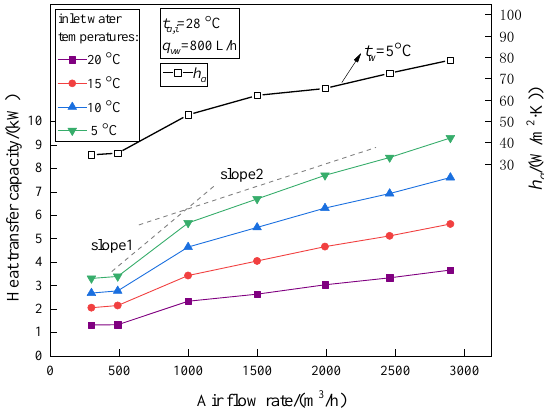
Figure 12. Variation of heat transfer rate and h a .